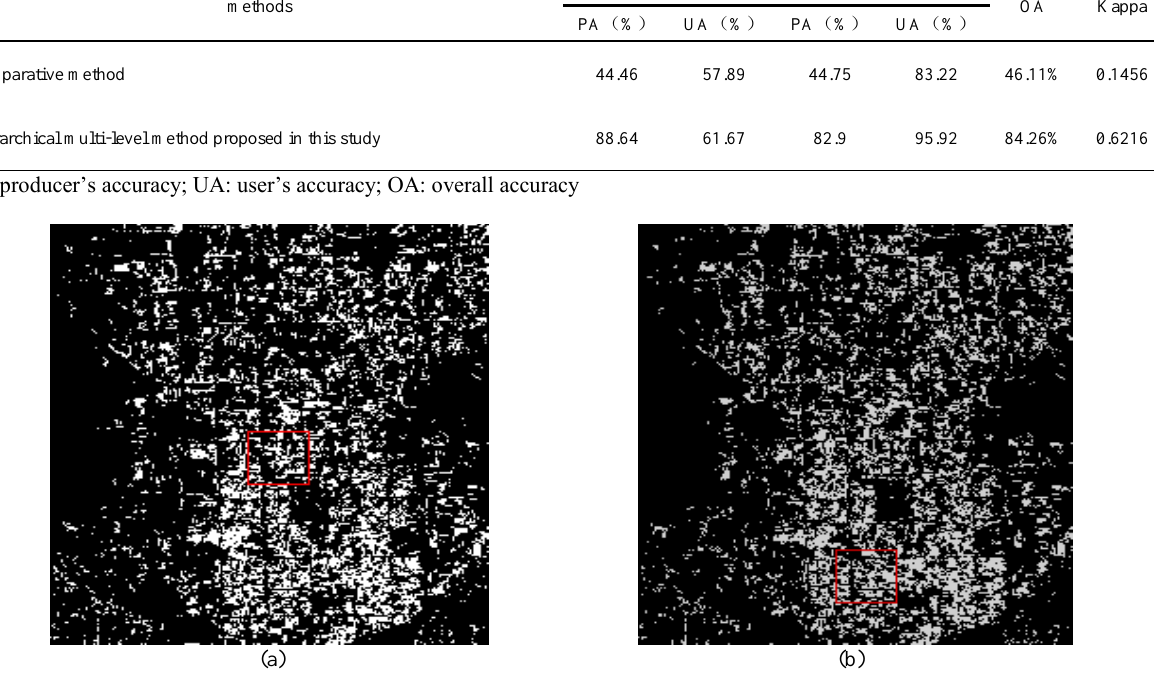
Figure 6 detection result by using (a) comparative method (b) hierarchical multi-level method proposed in this study. Figure 6 shows the detection result by using comparative